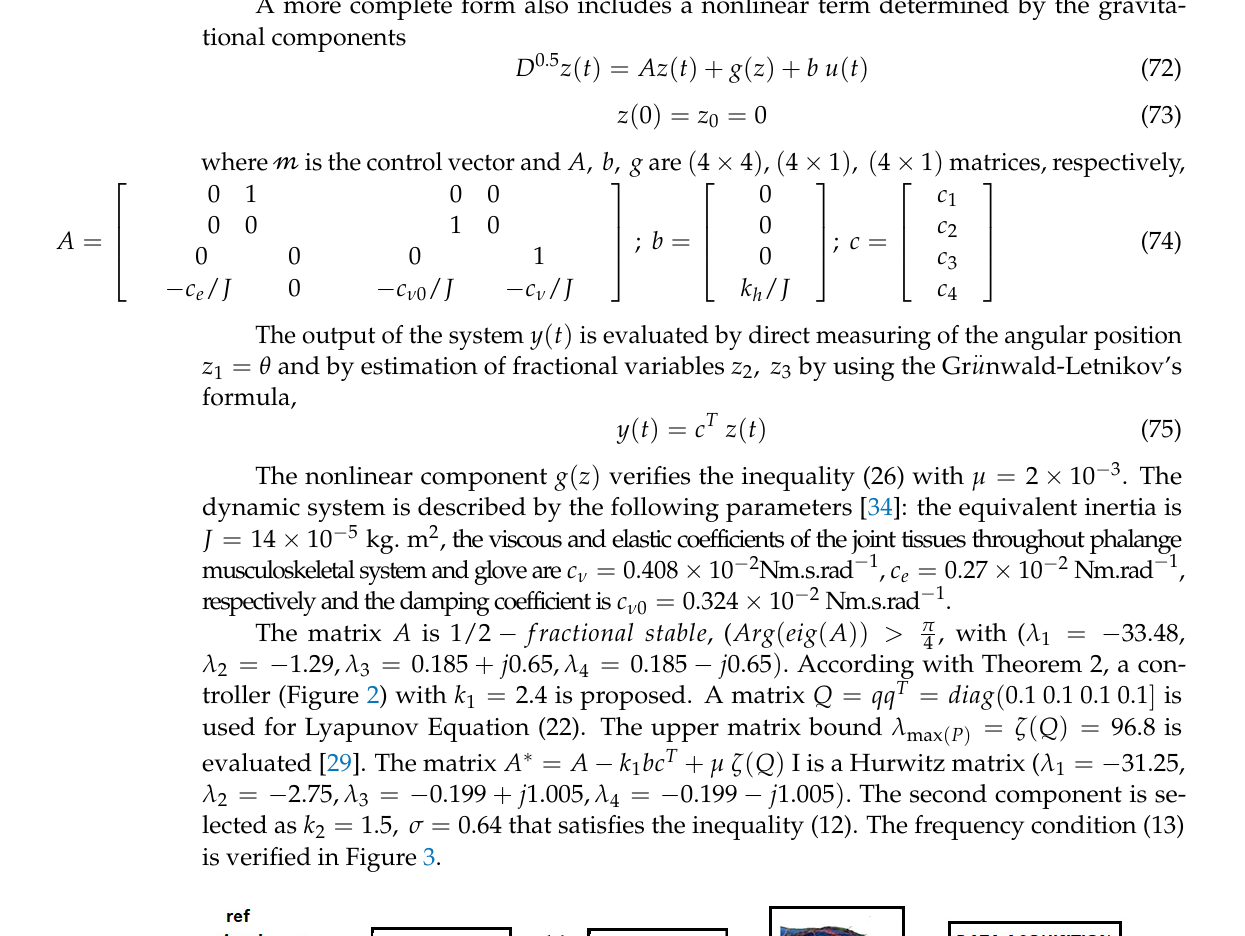
Figure 1. Exoskeleton Glove and its biomechanical components.